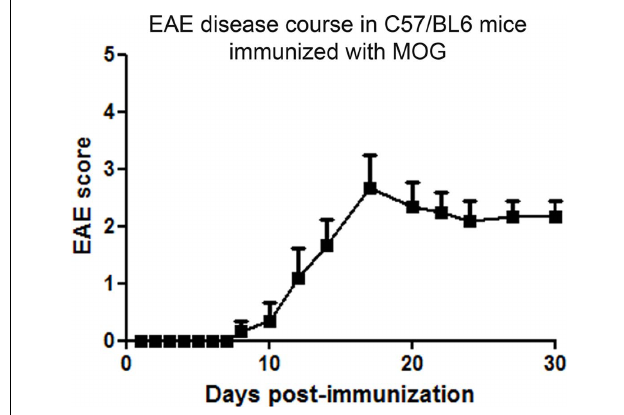
FIGURE 1 | Chronic progressive course of clinical EAE. C57/BL6 mice were immunized with MOG on day 0 and injected with pertussis toxin on day 0 and 2. Mice were observed daily for clinical signs of EAE. Clinical EAE was first detected at day 8 after immunization, and increased through day 17 before reaching a chronic level. One of four experiments is shown. Data represent average (mean ± SEM) EAE score of n = 6 mice.